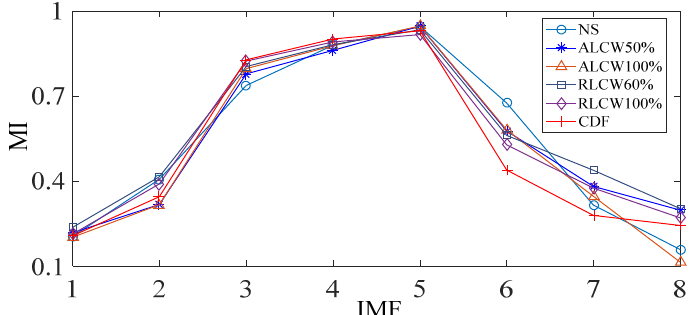
Figure 10. Corresponding MI value curve of the IMF components under different working condi- tions.